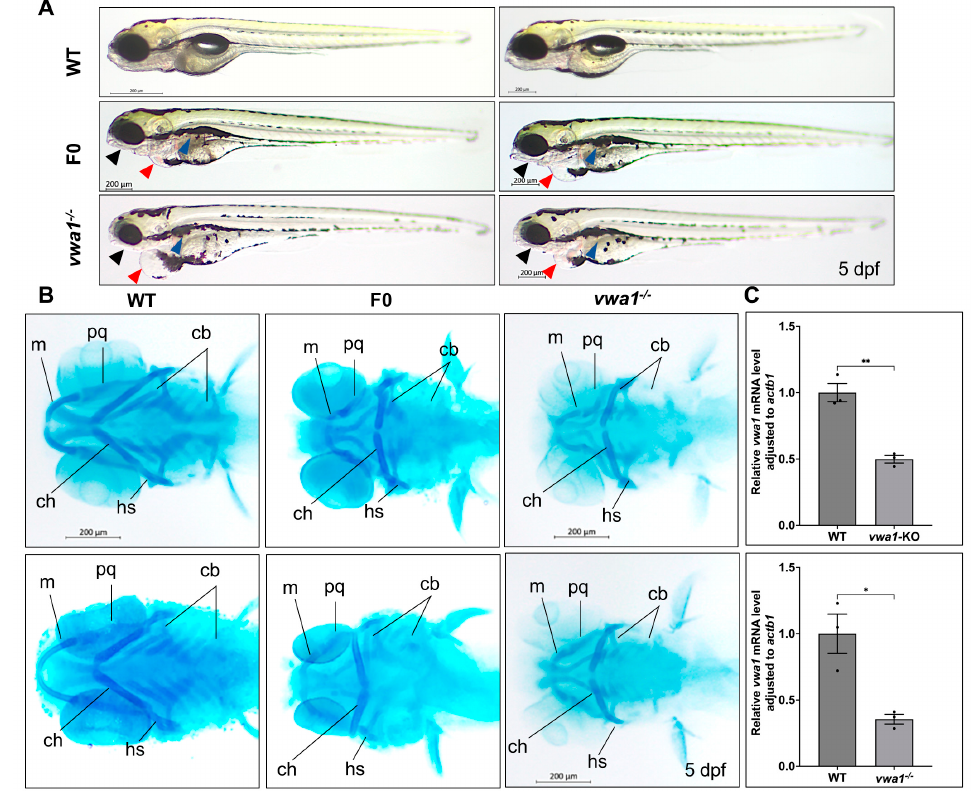
Figure 2. vwa1 knockout in zebrafish causes craniofacial defects. ( A ) General phenotypic changes in F0 mosaic and F2 homozygous embryos. Morphology was assessed at 5 dpf; un-injected WT larvae were used as controls (WT). Black arrow, lower jaw underdevelopment. Blue arrow: altered swim bladder development. Red arrow: pericardial edema. ( B ) Cartilage formation at 5 dpf, detected by Alcian Blue staining. Compared to controls, F0 crispants and F2 homozygous larvae showed hypoplastic Meckel’s cartilage and palatoquadrate, a significantly widened angle between ceratohyals, and a reduction in the number of hypoplastic ceratobranchial cartilages. m, Meckel’s cartilage; pq, palatoquadrate; cb, ceratobranchial; ch, ceratohyal; hs, hyosymplectic. ( C ) RT-qPCR analysis of vwa1 expression levels in F0 crispants and the -7-bp deletion mutant line at 5 dpf. n = 3 independent experiments. * p < 0.05; ** p < 0.01.